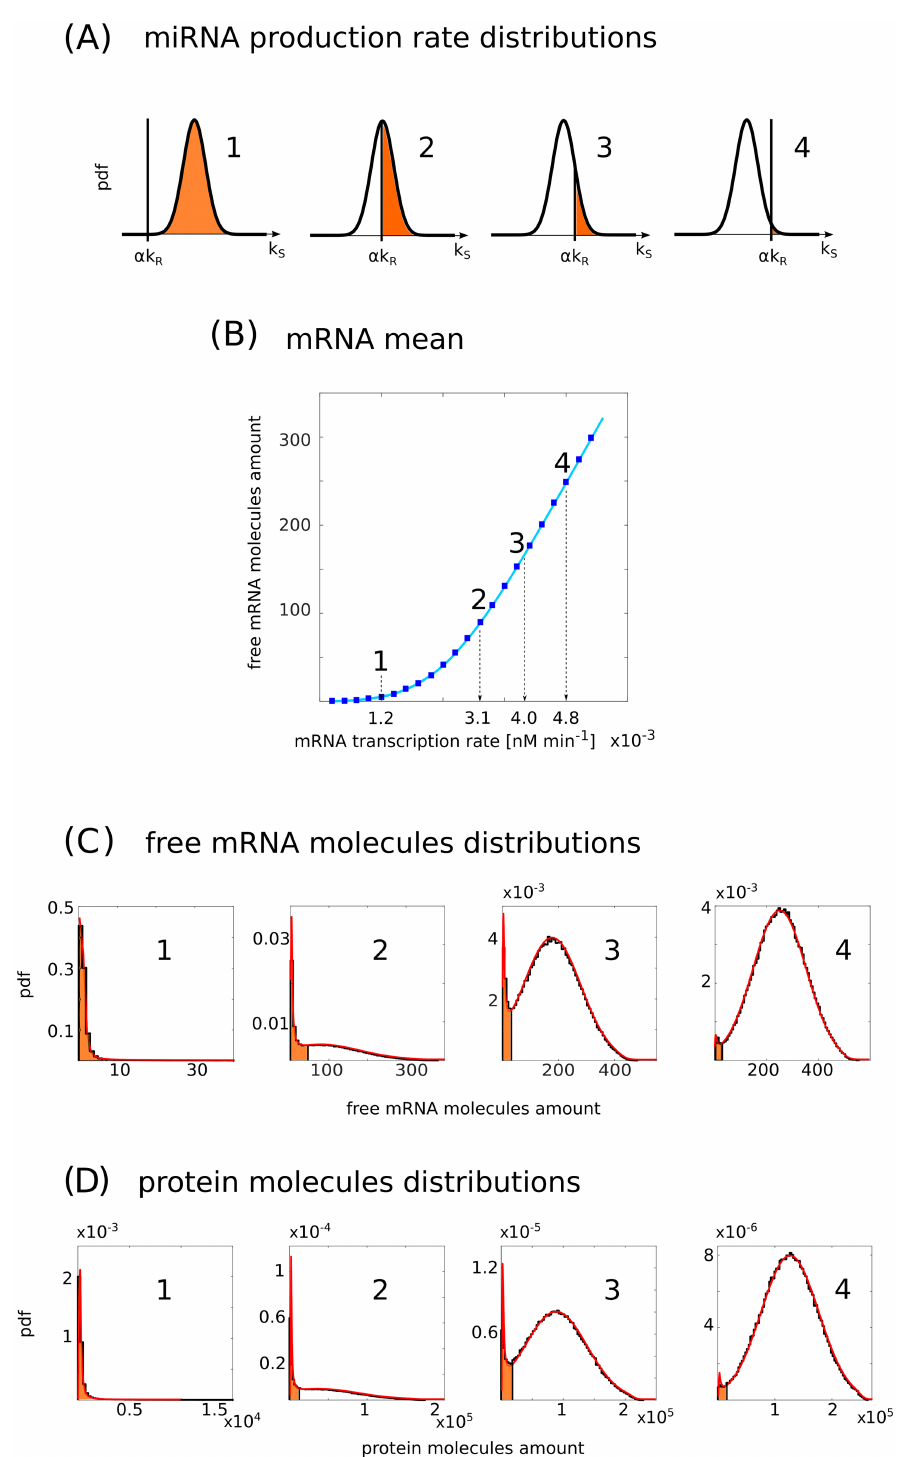
Fig 2. Emergence of bimodality in the presence of extrinsic noise. (A) Qualitative representation of the miRNA production rate distribution. The black vertical line indicates the value of the miRNA transcription rate k S = α k R for different values of the target transcription rate k . The distributions represent the different conditions labelled from 1 R to 4 shown in (B). The region of the distribution contributing to the repressed state is coloured in orange. (B) The amount of free mRNA molecules as a function of the target transcription rate k . Solid lines are analytic predictions R while blue squares correspond to numerical simulations. (C) Free mRNA molecule distributions corresponding to